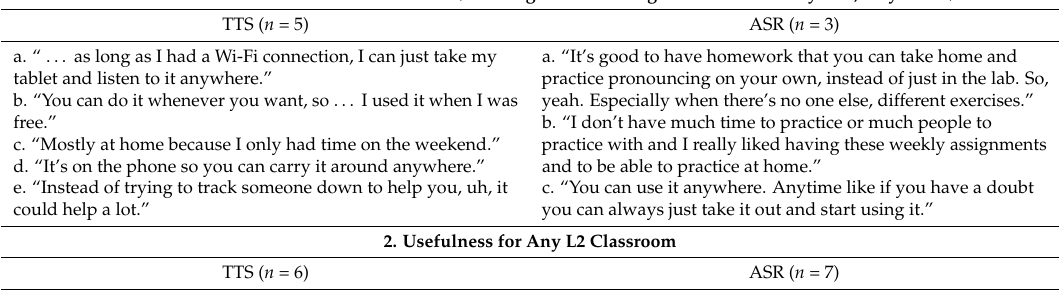
Table 2. Perceived strengths of TTS and